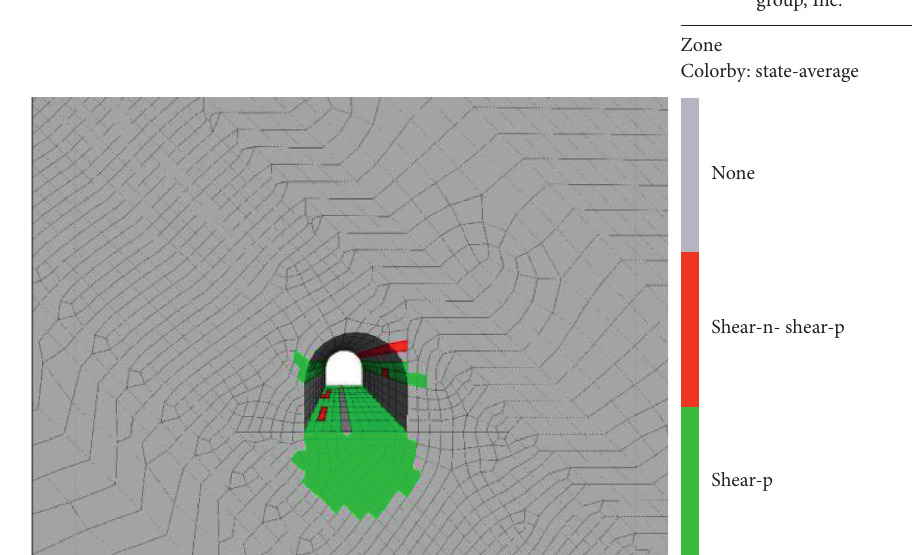
Figure 12: Distribution of plastic zone in surrounding rock of roadway.